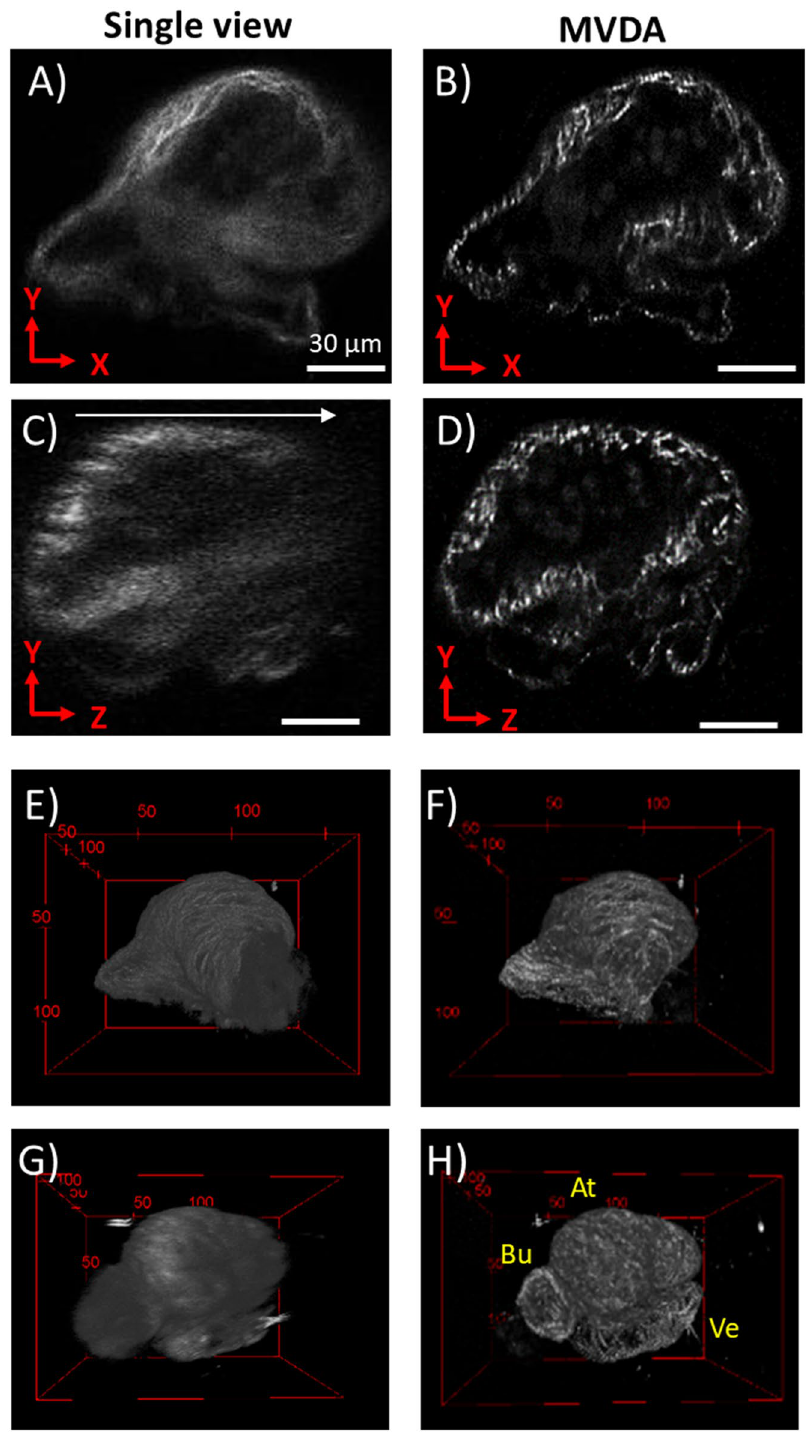
Figure 7. SHG images of 3-dpf zebrafish heart. ( A ) Single view YX imaging plane. ( B ) MVDA YX imaging plane. ( C ) SV sagittal section (YZ plane), arrow indicates direction of z-stack. ( D ) MVDA sagittal section. Scale bar: 30 μm. ( E – H ) 3D reconstructions of the zebrafish heart. ( E ), and ( G ) SV, ( F ) and ( H ) MVDA. ( F ) and ( H ) rotated 90° compared to ( E ) and ( G ) respectively. At: Atrium, Ve: Ventricle, Bu: Bulbus arteriosus. (Images were created with Fiji 26